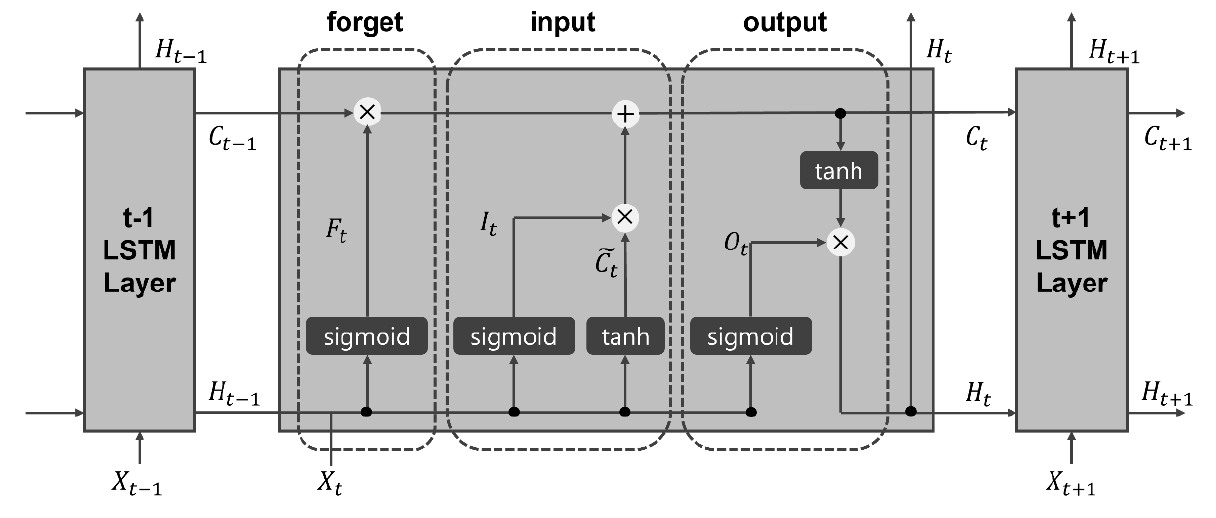
Figure 3. Architectures of the LSTM layer [22,23].